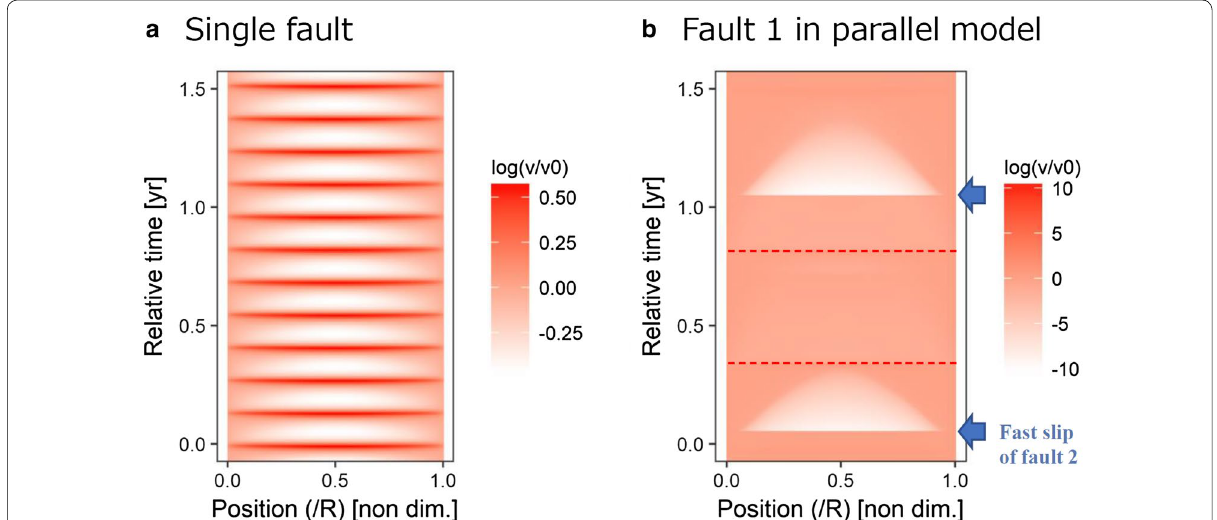
Fig. 7 Spatiotemporal evolution of the common logarithmic slip rate log( v / v 0 ) during multiple stick-slip sequence, in Case 5 with the slip law. a In case of the single fault. b In case of Fault 1 of the parallel model with x / R 0.1. The red and broken horizontal lines represent the time of fast-slip = events, and the blue arrows represent the time of fast-slip events of the other fault (Fault